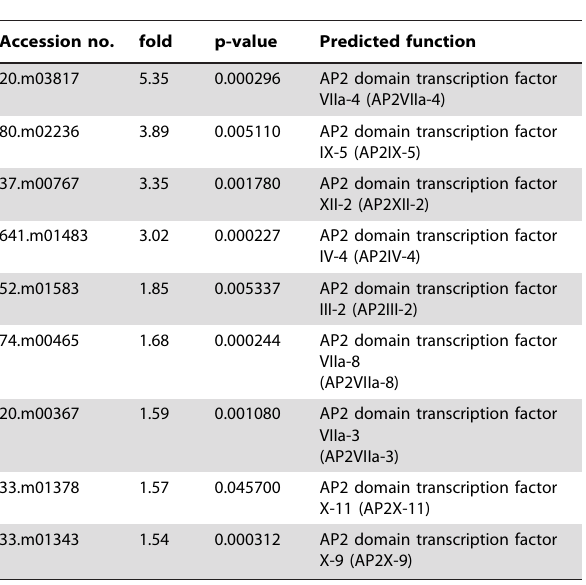
Table 2. Predicted AP2 proteins up-regulated during alkaline stress in